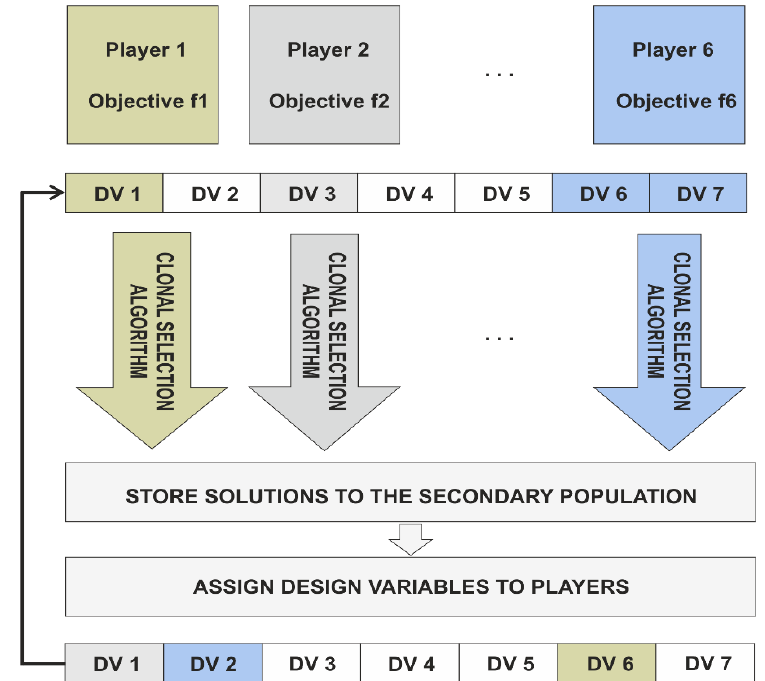
Figure 9. General schema of IMGAMO algorithm.